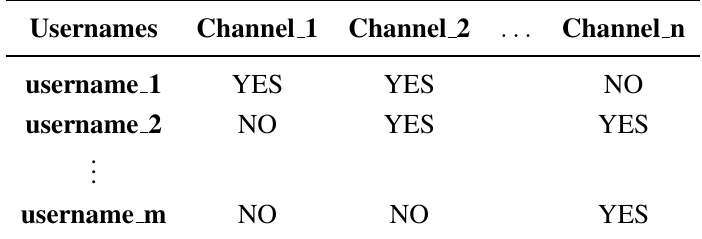
Table 1. Access control matrix for read access to information